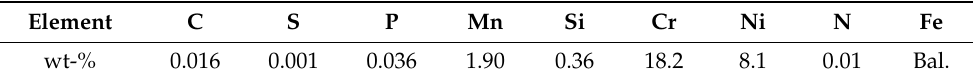
Table 1. Chemical composition of AISI 304 provided by the manufacturer.